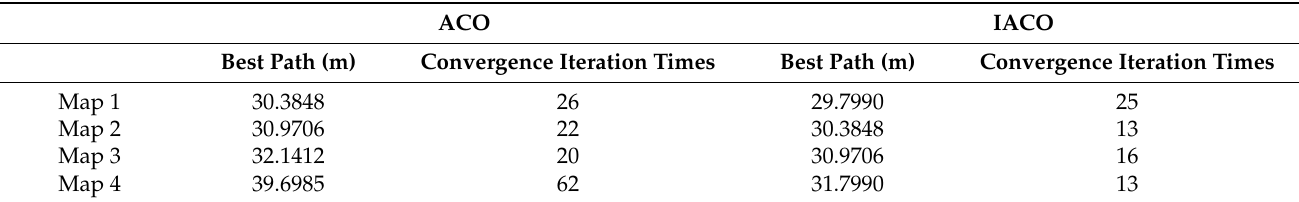
Table 3. Comparison of ACO and